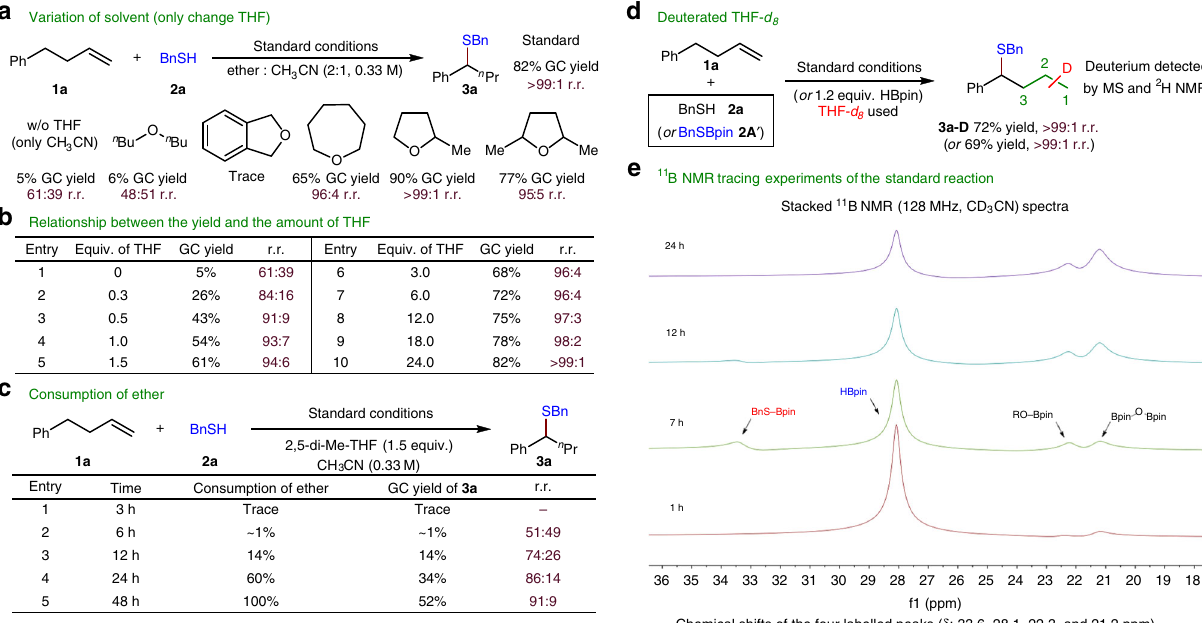
Chemical shifts of the four labelled peaks ( δ : 33.6, 28.1, 22.3, and 21.2 Fig. 8 Role of solvent tetrahydrofuran (THF). a Variation of solvent (only change THF). b Relationship between the yield and the amount of THF. c Consumption of ether. d Deuterated THF- d 8 . e Reaction progress monitored by in situ Boron-11 NMR ( 11 B NMR) (128 MHz, CD 3 CN) of the standard reaction